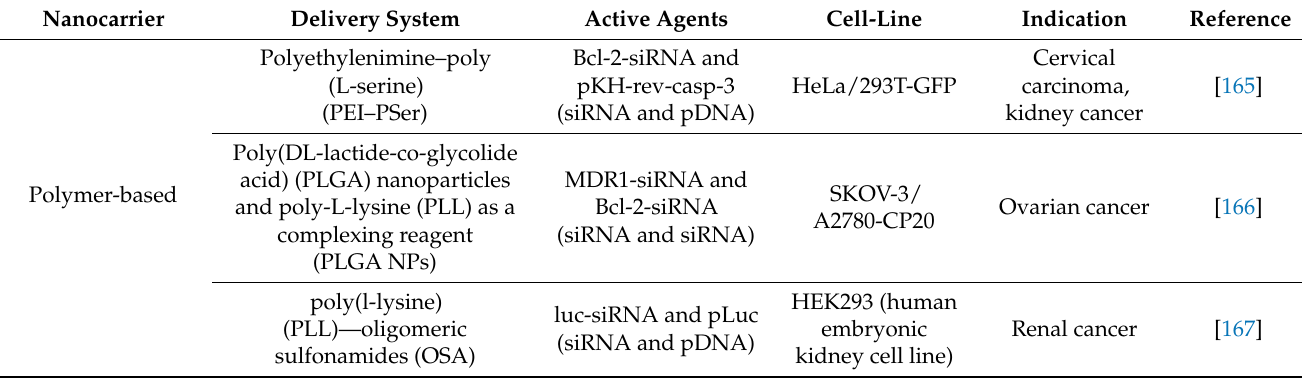
Table 5. Nanocarrier systems for dual delivery of nucleic acids for cancer